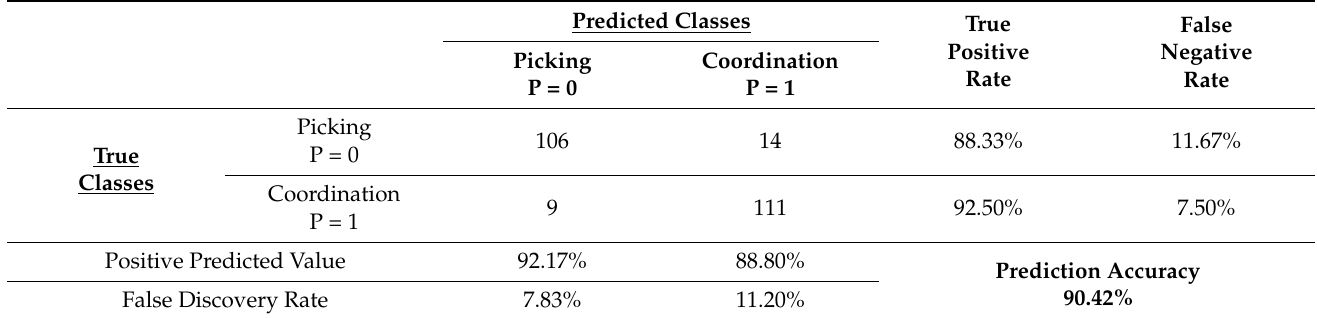
Table 3. Classification results—random forest using anonymous walk of length 5.